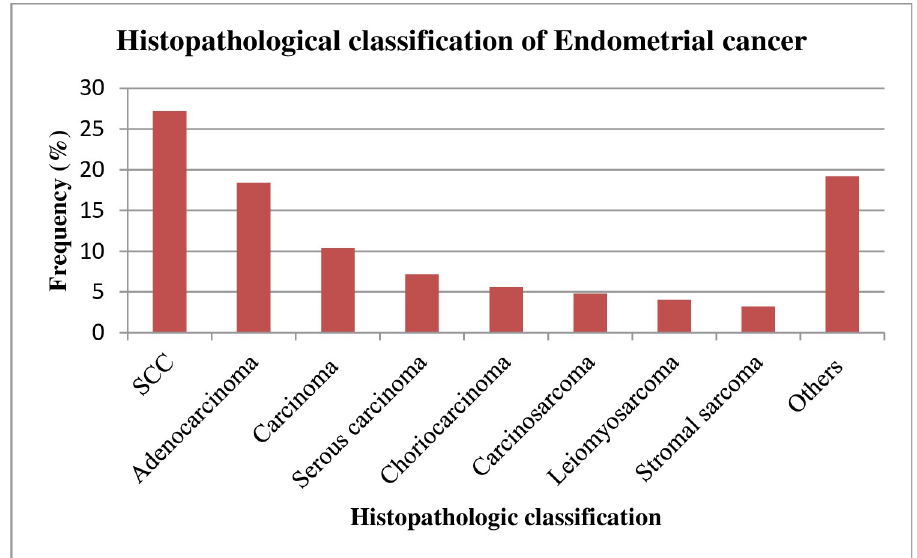
Fig 3. Histopathological classification of endometrial cancer, 2014–18, SPHMMC. SCC: Squamous cell carcinoma.